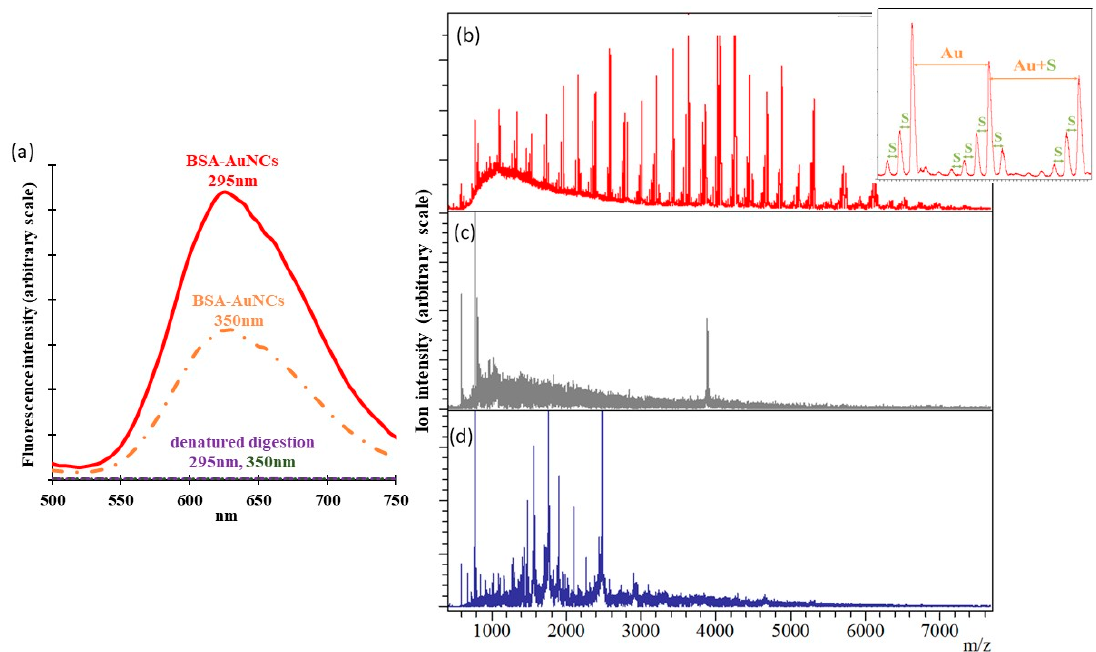
Figure 1. ( a ) Fluorescence of BSA-AuNCs and denature-digested BSA-AuNCs excited at 295 or 350 nm. [Au n S m ] signals in the low mass region of MALDI-MS detected from ( b ) BSA-AuNCs solution, ( c ) BSA solution, and ( d ) denature-digested BSA-AuNCs. The enlarged spectra pattern of ( b ) is shown in the